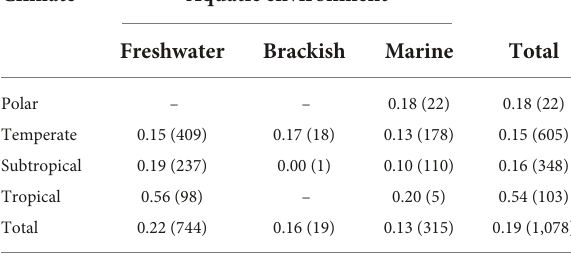
TABLE 2 Senescence in different reproductive traits separated for male and female